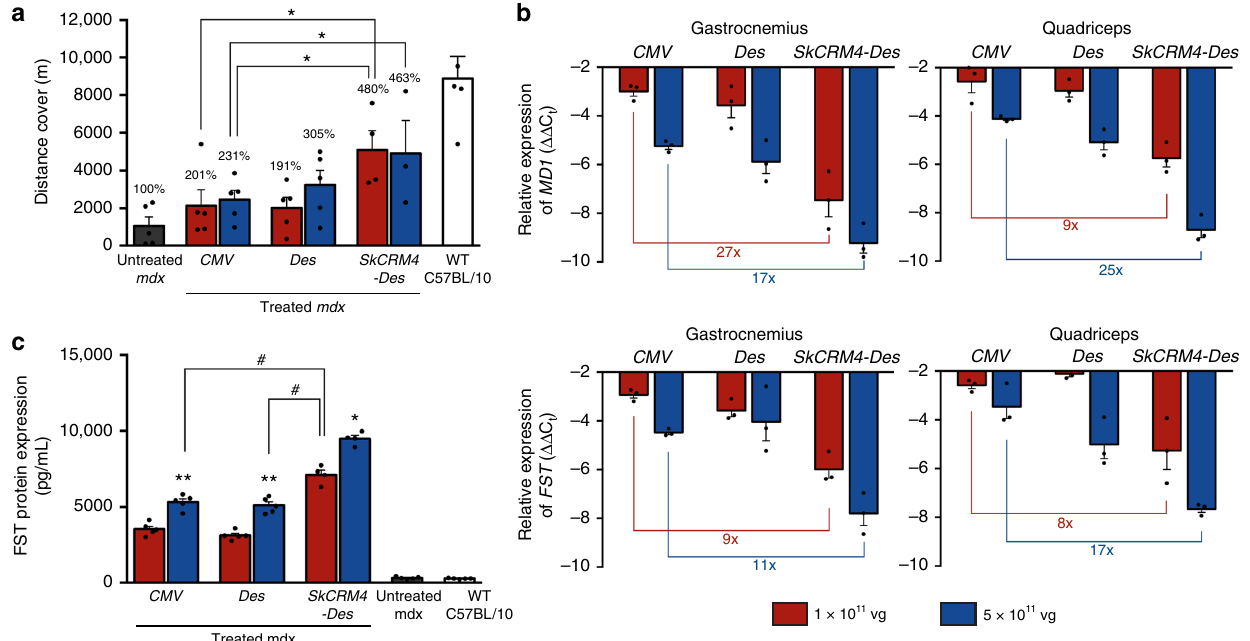
Fig. 8 Comparison of Sk-CRM4/Des chimeric promoter with conventional promoters in mdx mice model. The ssAAV9 vectors encoding MD1 and FST gene under Sk-CRM4/Des chimeric promoter, Des , or CMV were co-injected as a combination therapy into mdx mice at a dose of 1 × 10 11 vg/mouse or 5 × 10 11 vg/mouse. a Treadmill test of the 20-week-old mdx mice (16 weeks post-injection) treated with the different constructs of therapeutic vectors compared to the untreated mdx and wild-type C57BL/10ScSnJ mice. The results were shown as the distance covered. The percentages indicate the distance